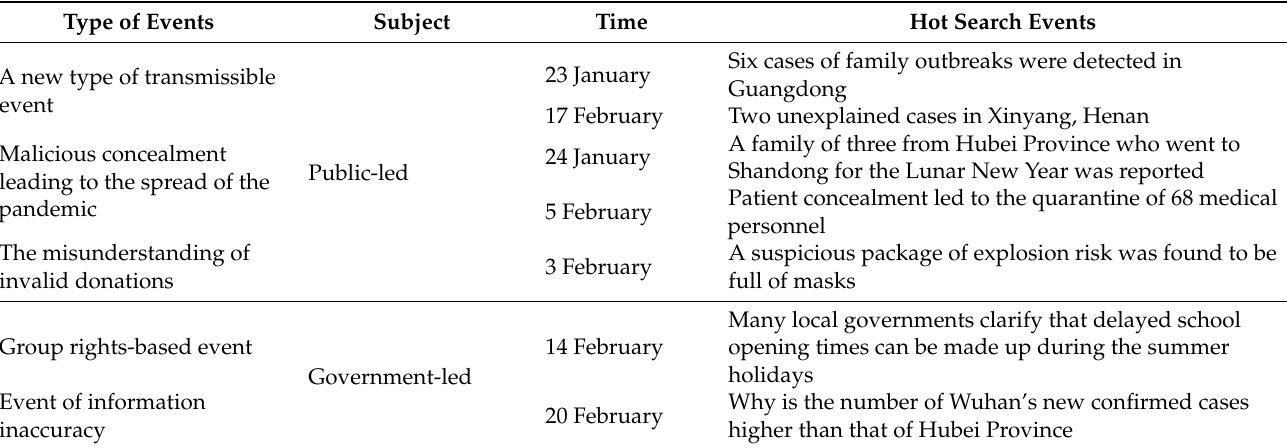
Table 2. Hot Search events corresponding to sentiment value